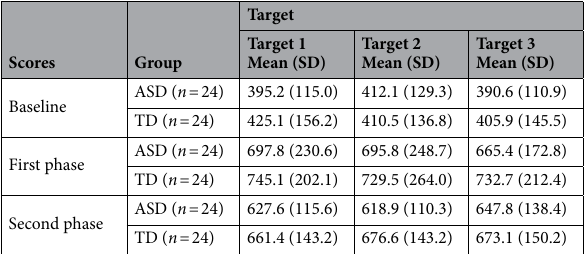
Table 2. RTs (ms) in all phases and target locations. RTs: reaction times (ms); ASD: autism spectrum disorder; TD: typically developing; SD: standard